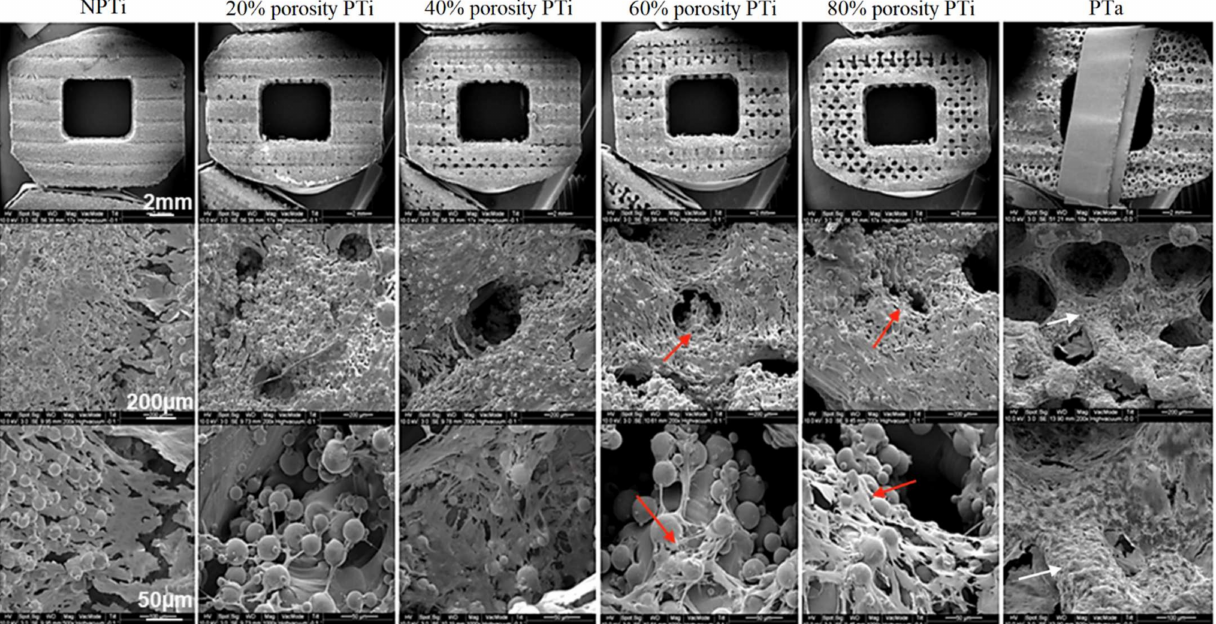
Figure 6. In vitro results for cell attachment. Scanning electron micrographs of nonporous titanium (NPTi), porous titanium (PTi), and porous tantalum (PTa) cages. Upper row, 1.7 × ; middle row, 200 × ; lower row, 500–1000 × . Among the examined cages, 60% and 80% PTi cages exhibited more favorable results for cell migration inside pores (red arrows), cluster formation inside pores, and cell linkage; the PTa cage had a flatter cell morphology (white arrows), and cells were less interconnected on its